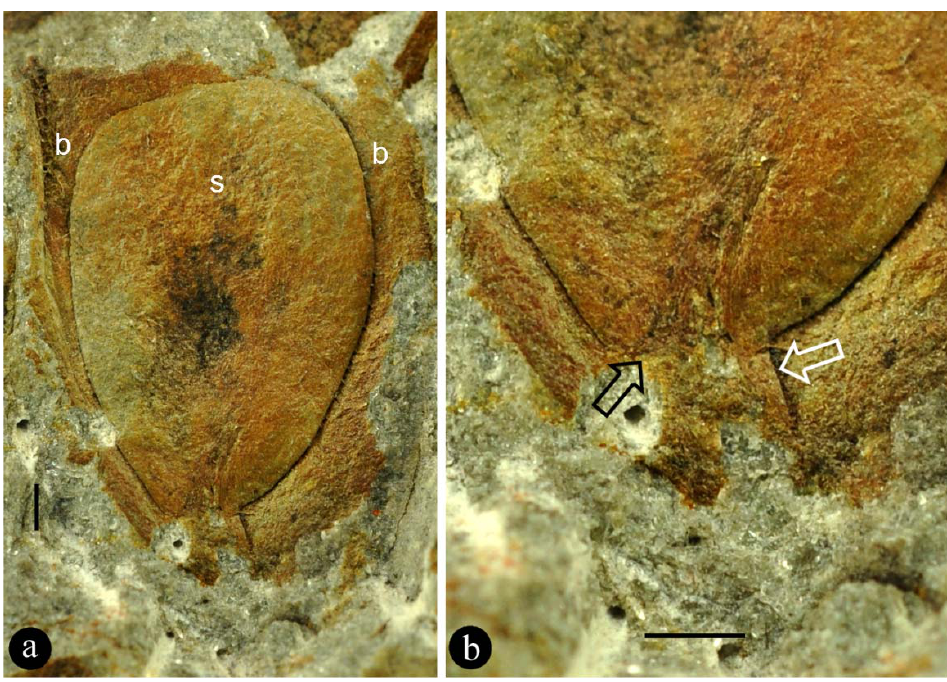
Figure 2. An isolated part associated with the holotype of Combina gen. et sp. nov. ( a ). An adaxial view of an anatropous ovule (s) in a bract (b) axil. Specimen number R4/40/38/5. Scale bar = 1 mm. ( b ). Detailed view of the ovule base in Figure 2a, showing the asymmetrical funiculus (white arrow) and the micropyle (black arrow) of the anatropous ovule. Scale bar = 1 mm.